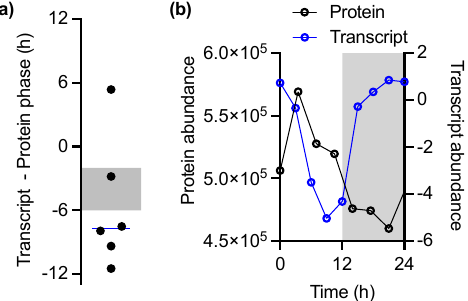
not (Figure 4a, shaded box). An example is provided in Figure 4b, where the protein and